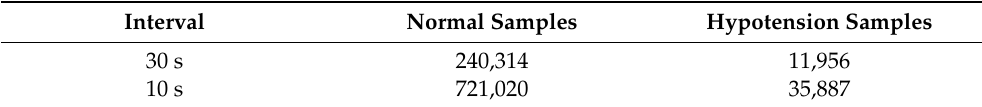
Table 1. The number of normal samples and hypotension samples with different windowing interval. Interval